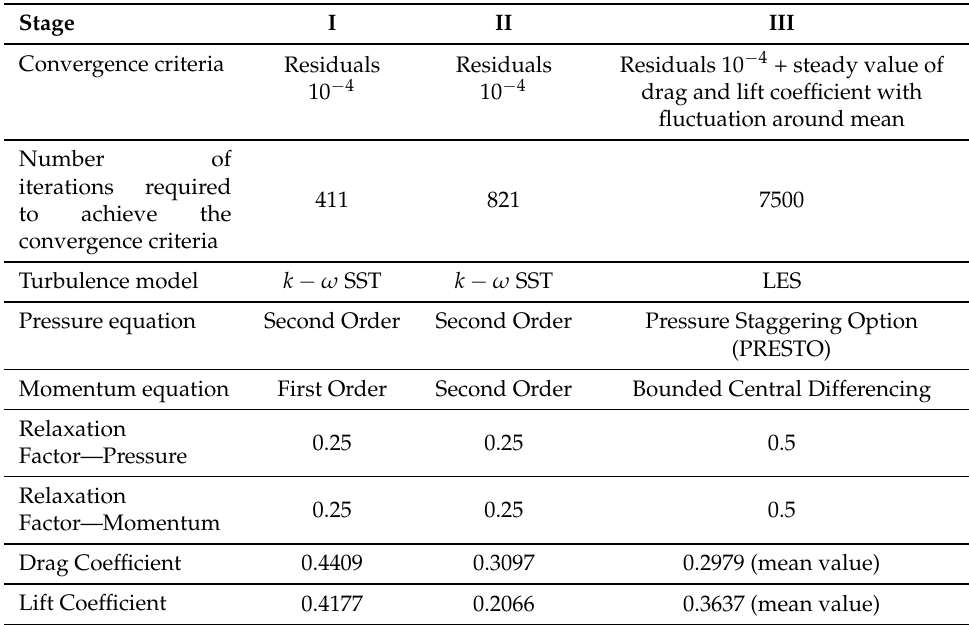
Table 1. Solution methods and convergence criteria for each stage of the simulation process.